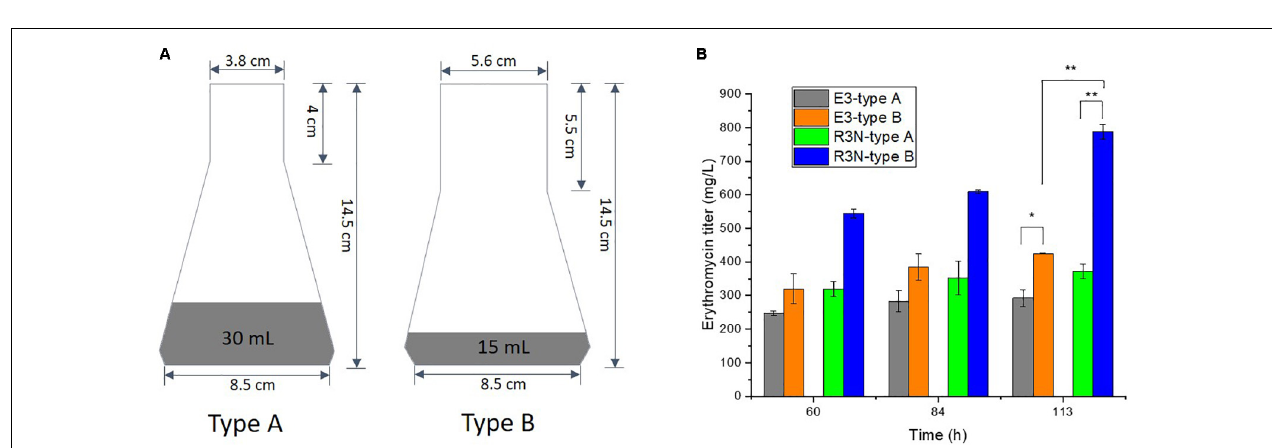
FIGURE 4 | The expression of NOX redirected secondary metabolism. The NOX-expression strains produced more erythromycin in the minimal liquid medium (A) and the complex medium (B) , while the pigment production in the NOX-expression strains reduced dependent on the level of NOX expression in the minimal liquid medium (C) . Data are shown as mean ± standard deviation from at least three independent experiments for erythromycin determination. *, P -value < 0.05.